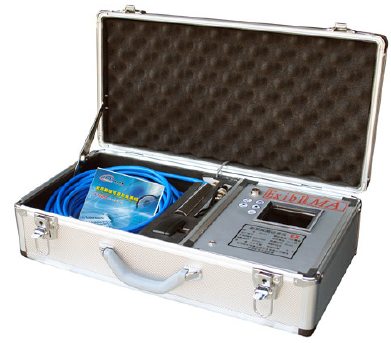
Figure 1. YTJ20 rock stratum detection recorder.